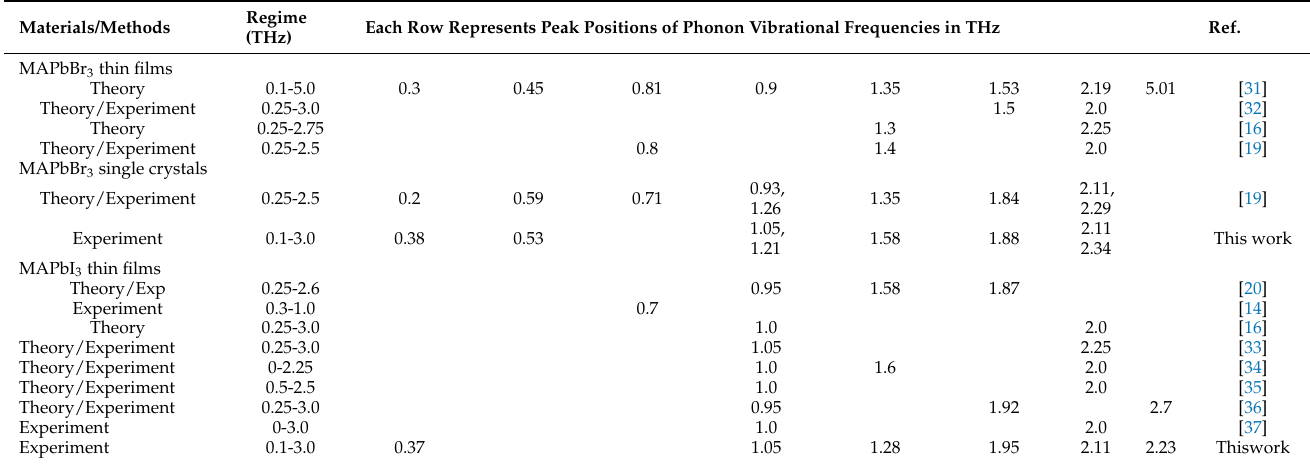
Table 1. Literature review for phonon vibrations for thin films and single crystals of MAPbBr 3 and MAPbI 3